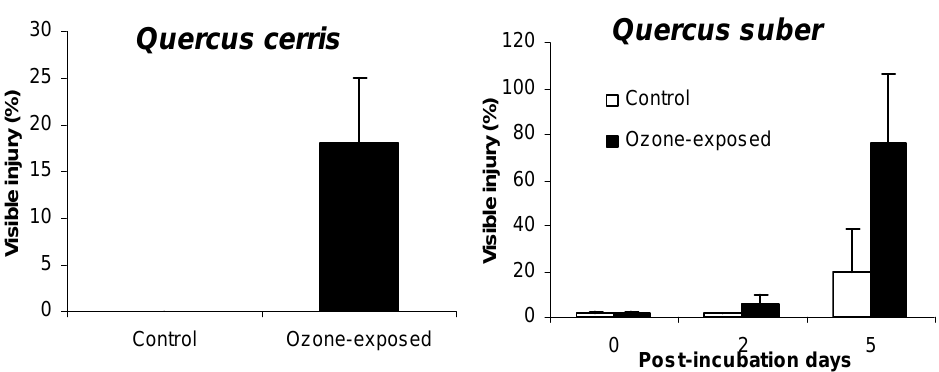
FIGURE 1. Percent of injured vs. total leaf area (+SD) after a 2-day incubation (day 0) of control (charcoal-filtered) and O 3 -exposed (110 ppb O 3 , 5 h day –1 , 30 days) seedlings in a humid chamber. Quercus cerris and Q. suber were inoculated with suspensions of B. mediterranea ascospores and D. corticola conidia, respectively. In Q. suber , leaf visible injury was assessed also at day 2 and 5 after incubation. n = 6.